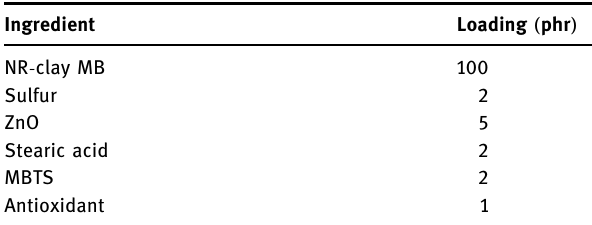
Table 1: Formulation of nanocomposite